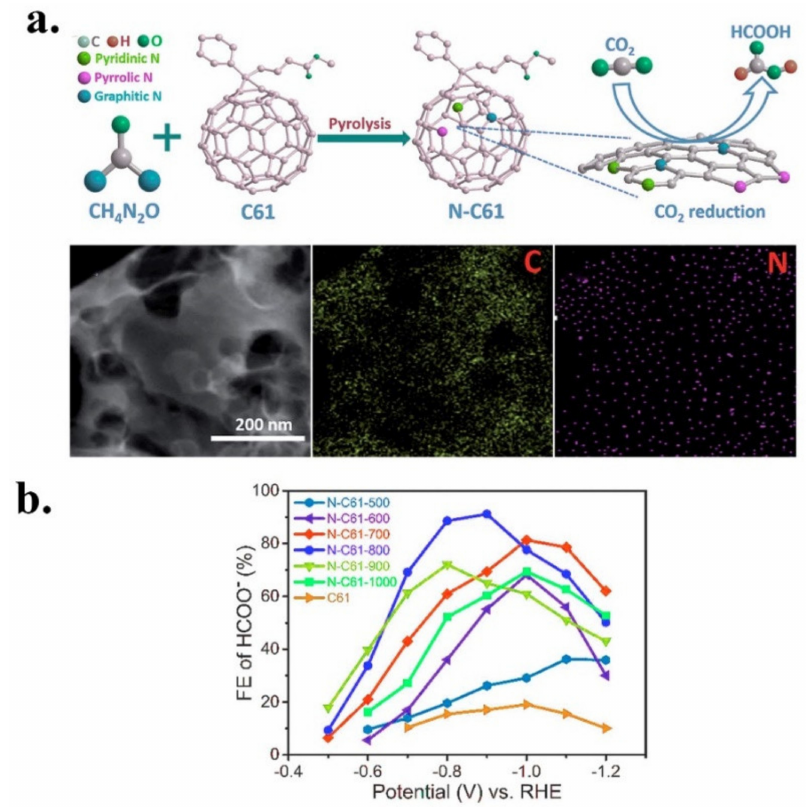
Figure 7. ( a ) Scheme of the synthesis of N-doped C61, SEM images and EDX mapping. ( b ) Variation of the maximum formate FE with the potential for the different samples. Adapted from